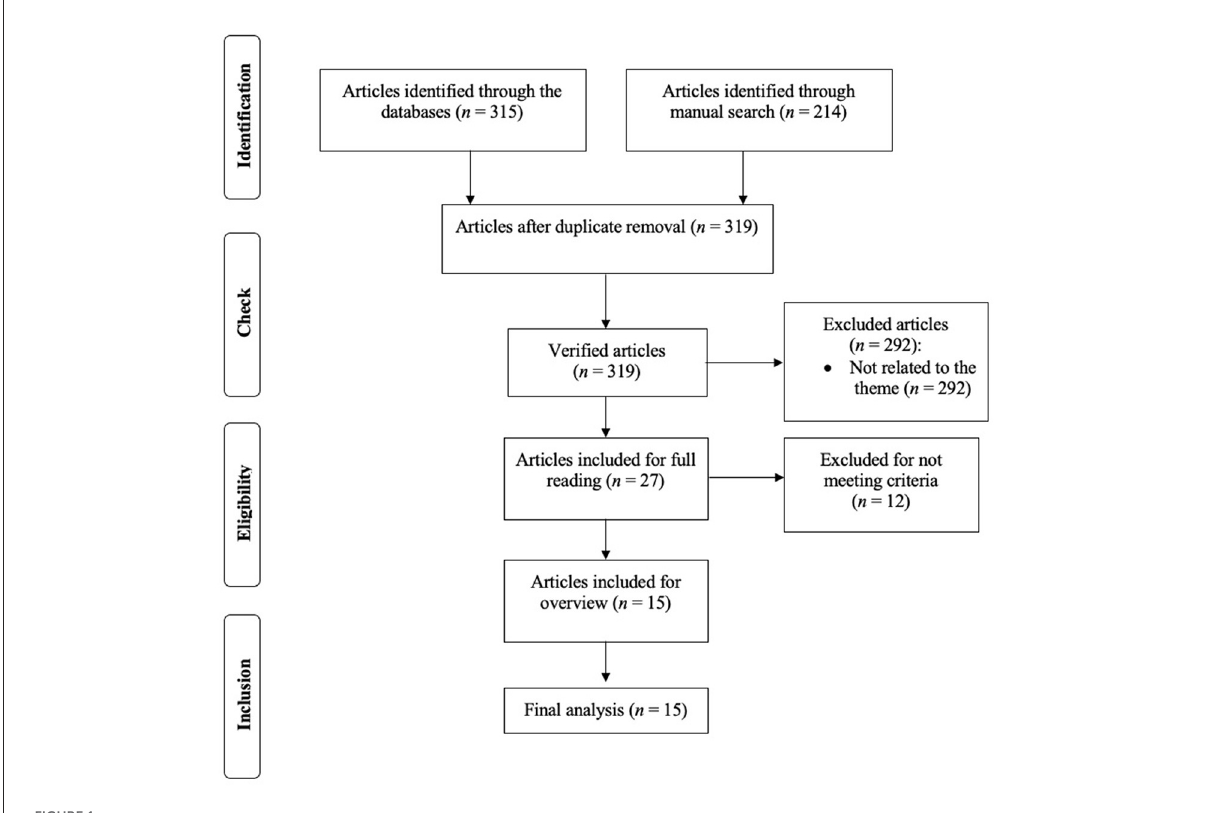
FIGURE1 Diagram of